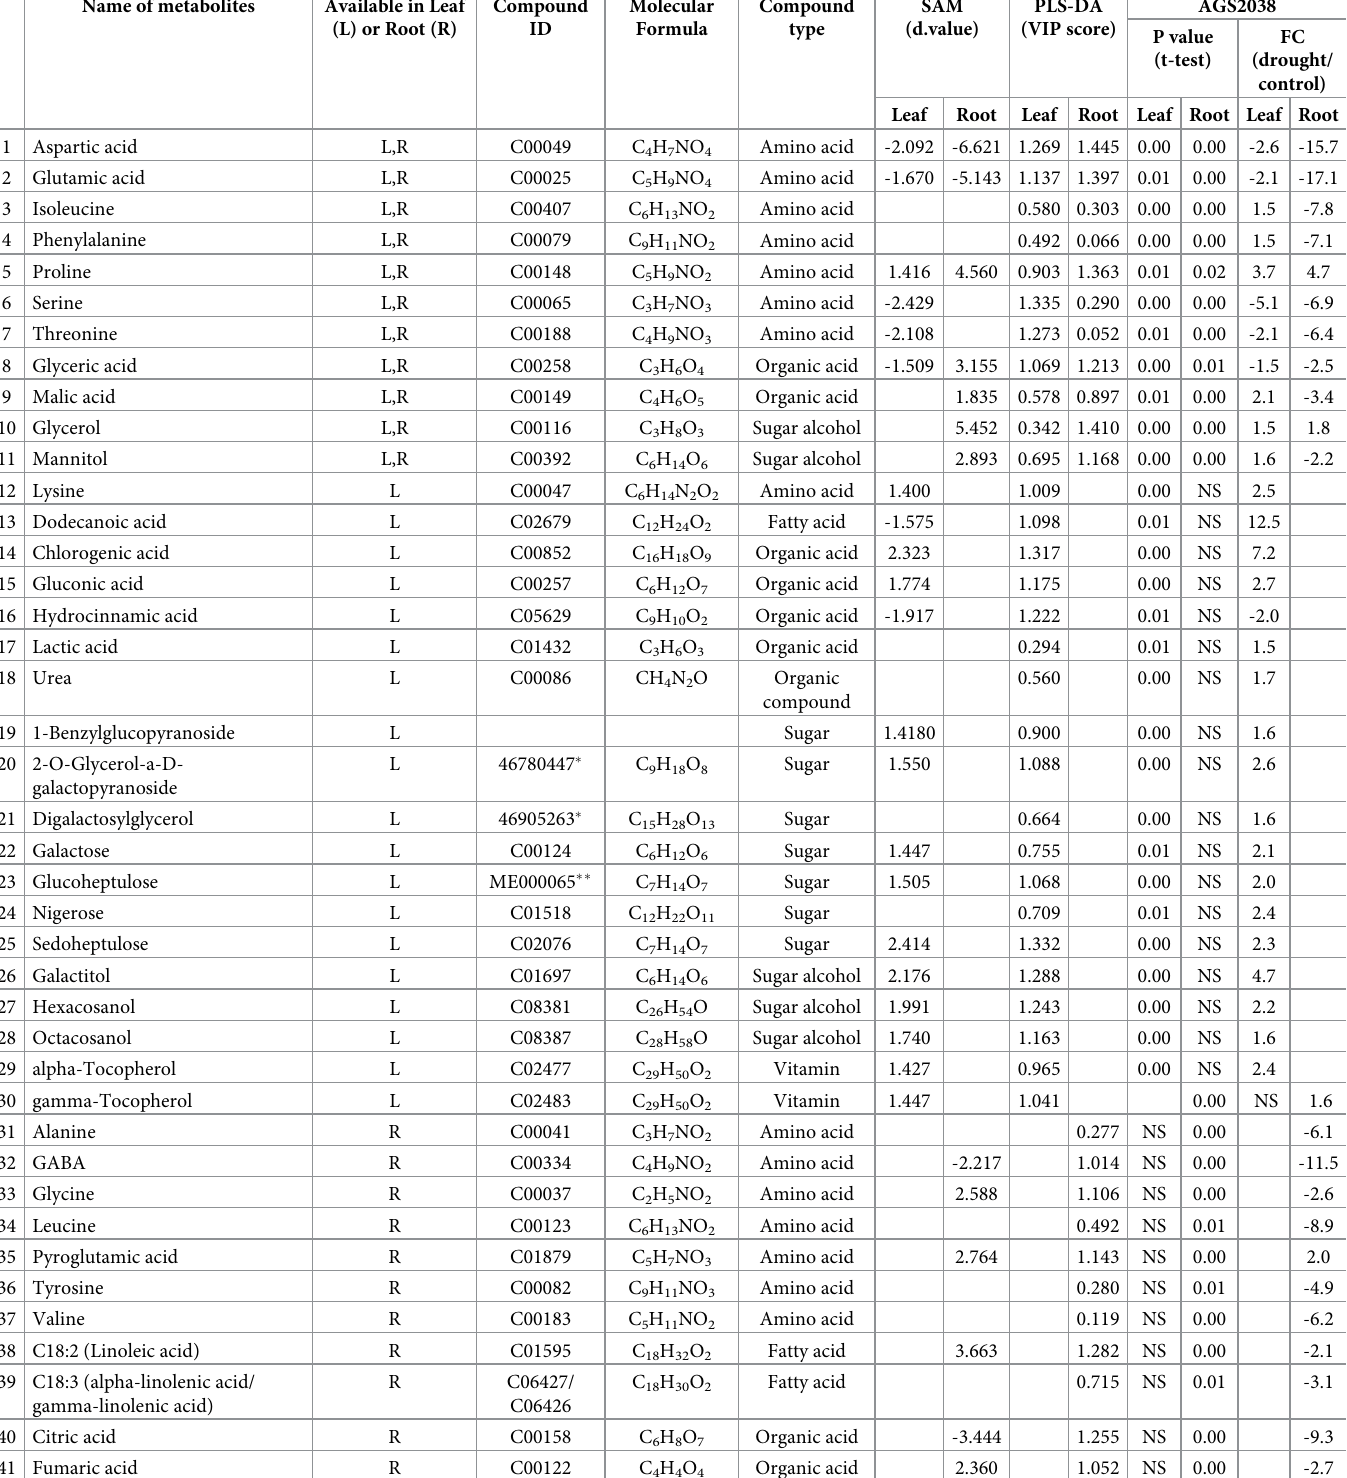
Table 4. List of 47 important metabolites with their Kyoto Encyclopedia of Genes and Genomes identifier number (KEGG ID/PubChem CID � /Metabolite ID( �� )), molecular formula (MF), identified through Significant Analysis of Metabolites (SAM) and Partial Least Square Discrepant Analysis (PLS-DA) in AGS2038. Name of